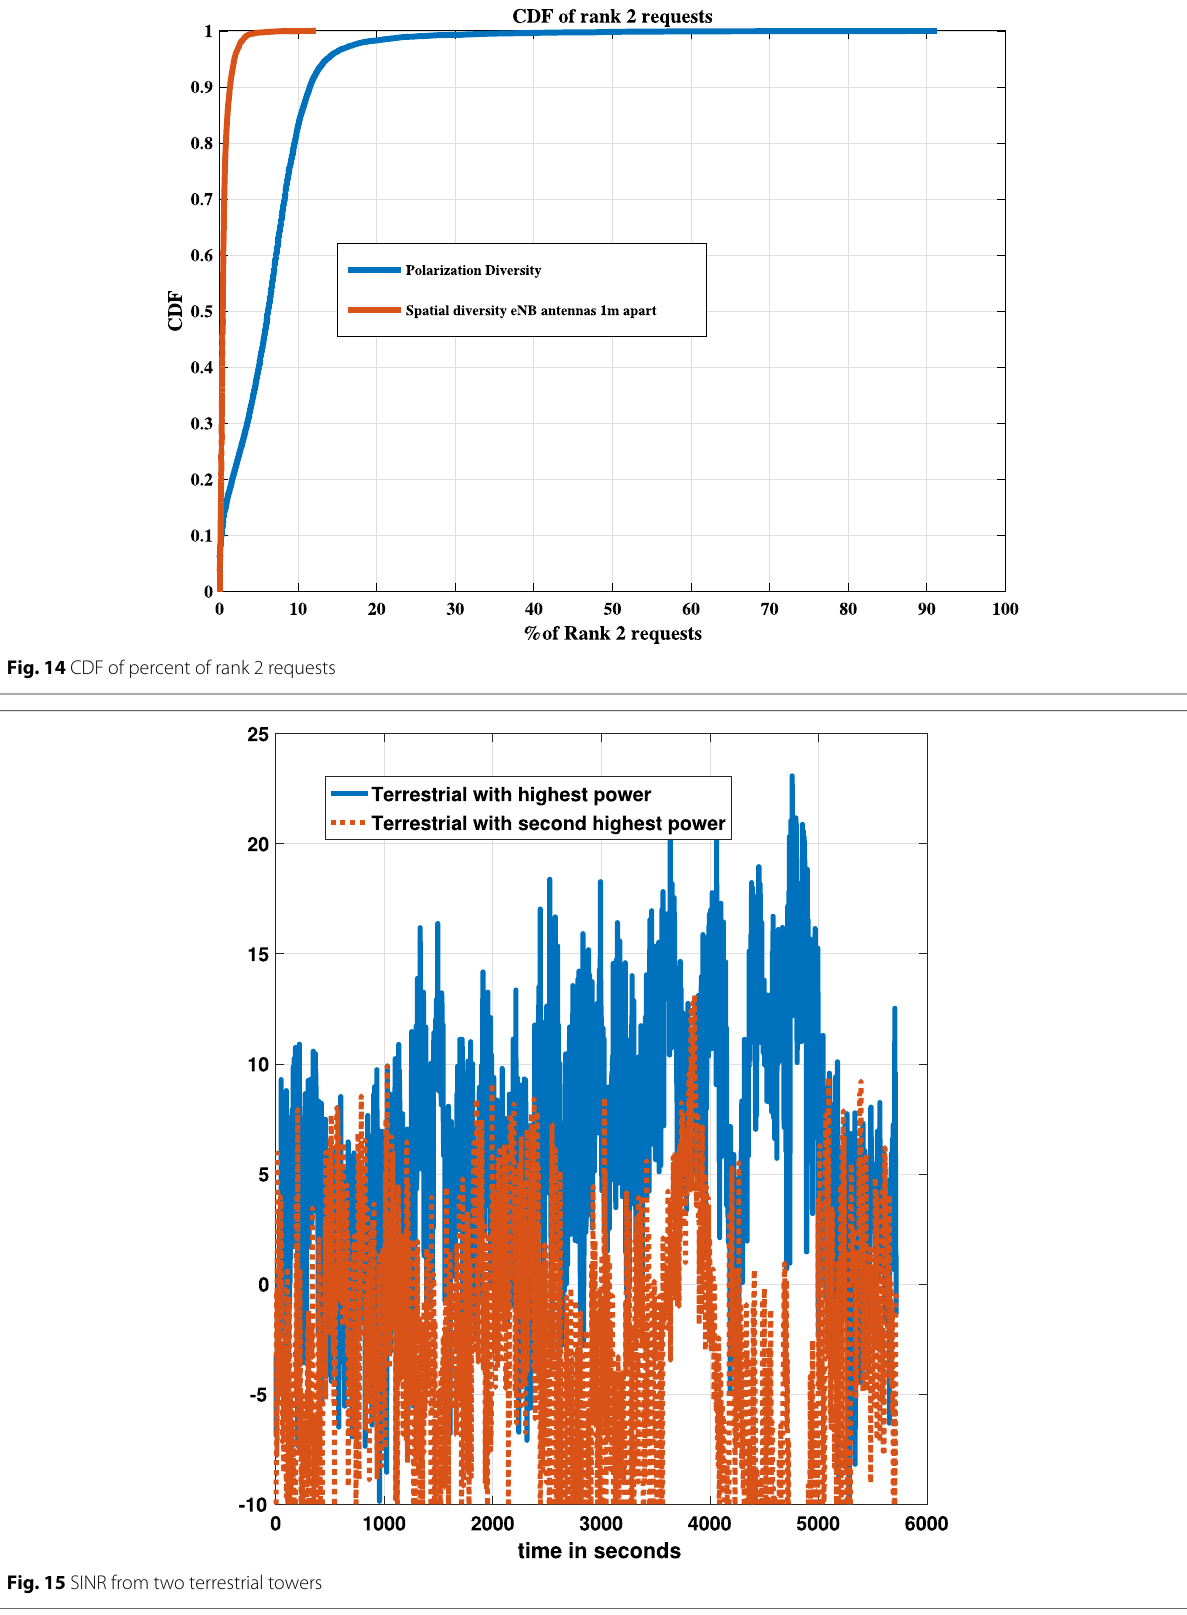
Fig. 15 SINR from two terrestrial